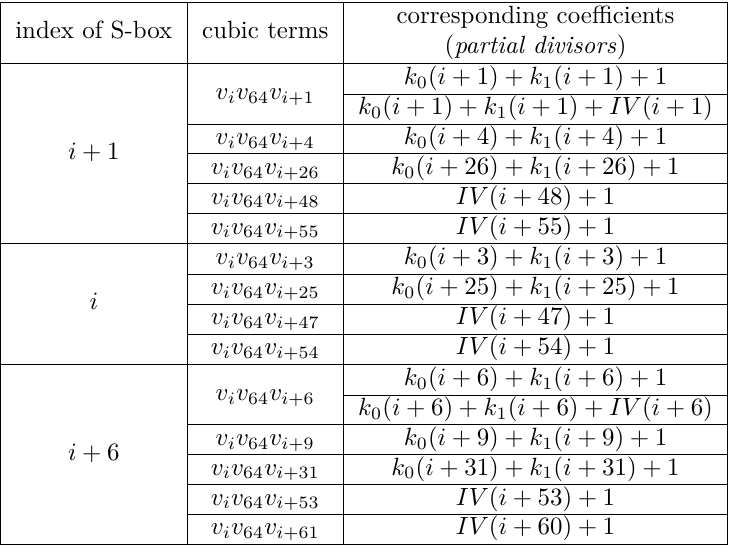
Table 4: Coefficients of Cubic Terms with No Additional Cube Set index of